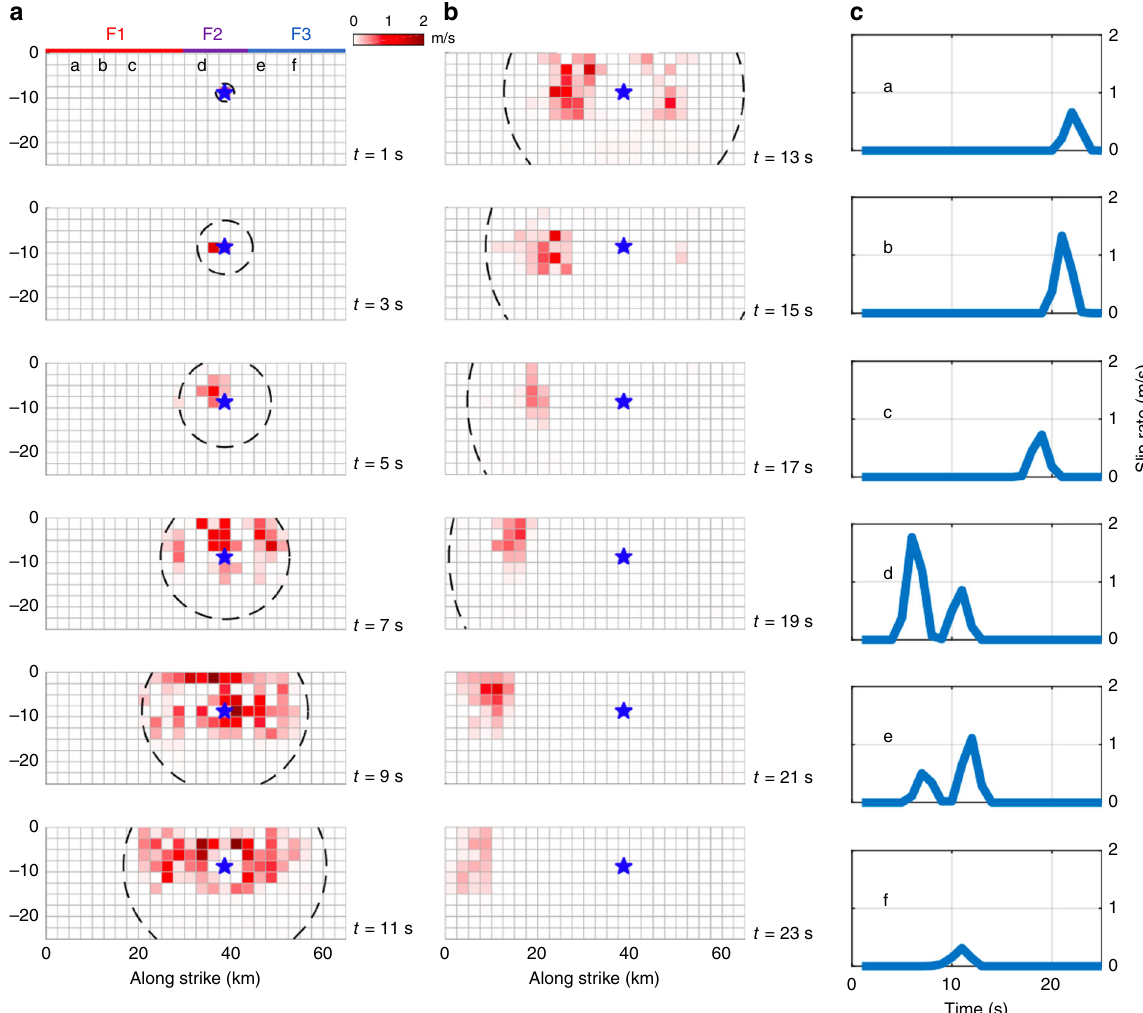
Fig. 4 Time evolution of the rupture during the M w 7.1 Ridgecrest earthquake. a , b Snapshots of the rupture expansion history every two seconds. Colours shading indicates the fault slip rate average over 2 s intervals. The black dashed contour presents the pseudo-rupture front with a rupture velocity of 2.0 km/s. F1, F2, F3 correspond to the faults in Fig. 3. c Presents slip rate at the six locations in a . Time is relative to the hypocentral